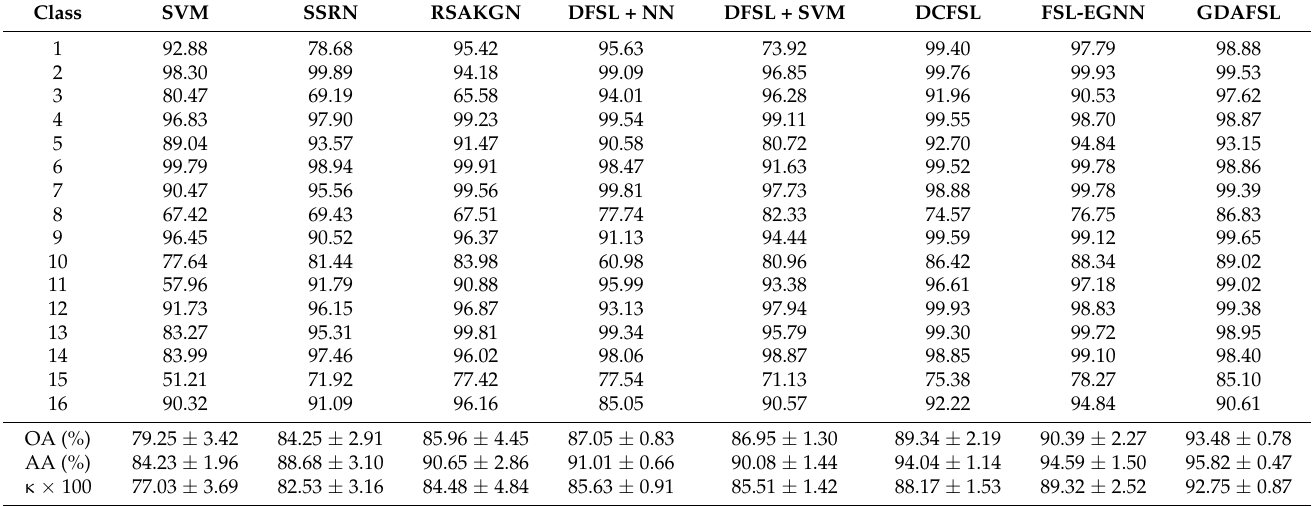
Table 9. Classification Results (%) of Various HSI Classification Methods on SV Dataset with 5 Labeled Samples Per Class.